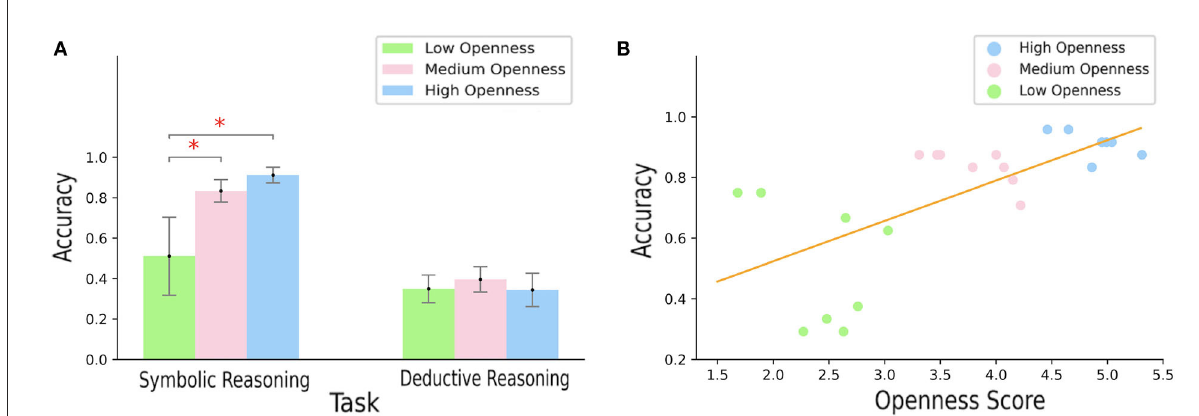
FIGURE3 (A) Participants’ accuracy according to the type of reasoning task—symbolic reasoning on the left-hand side and deductive reasoning on the right-hand side, (B) Pearson’s correlation scores computed between the openness scores and accuracy in the deductive task, according to the openness level—low, medium, and high openness corresponding respectively to green, pink, and blue bars/dots.